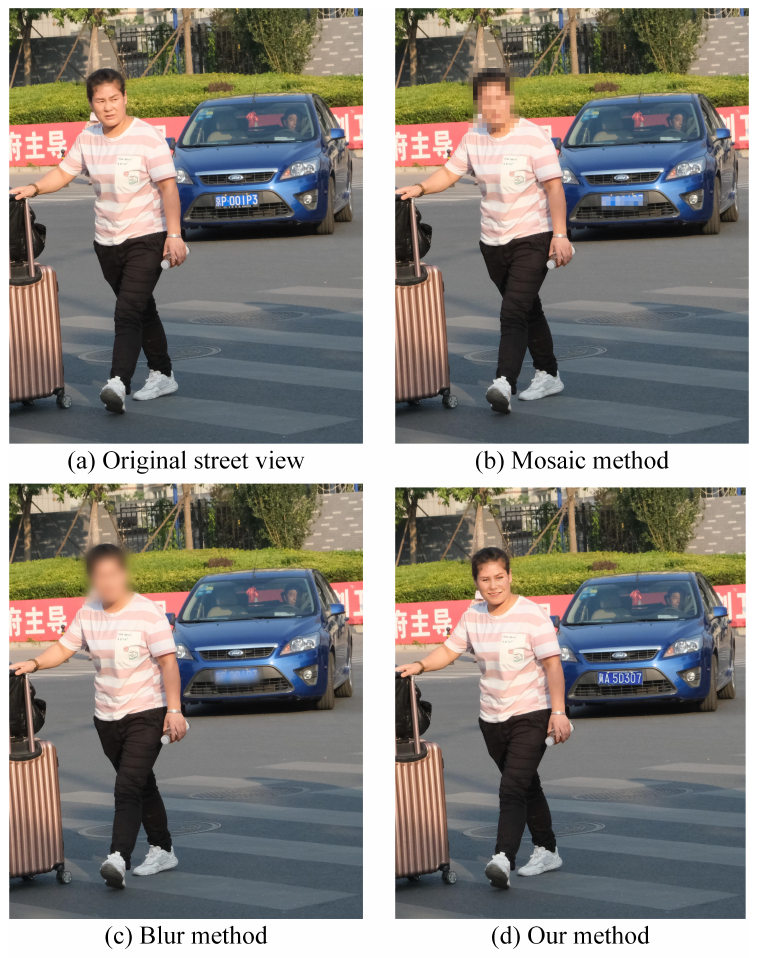
Figure 13. The result of four street view images: ( a ) unprotected image. ( b ) image processed with blur, ( c ) image processed with mosaic, ( d ) image processed with our